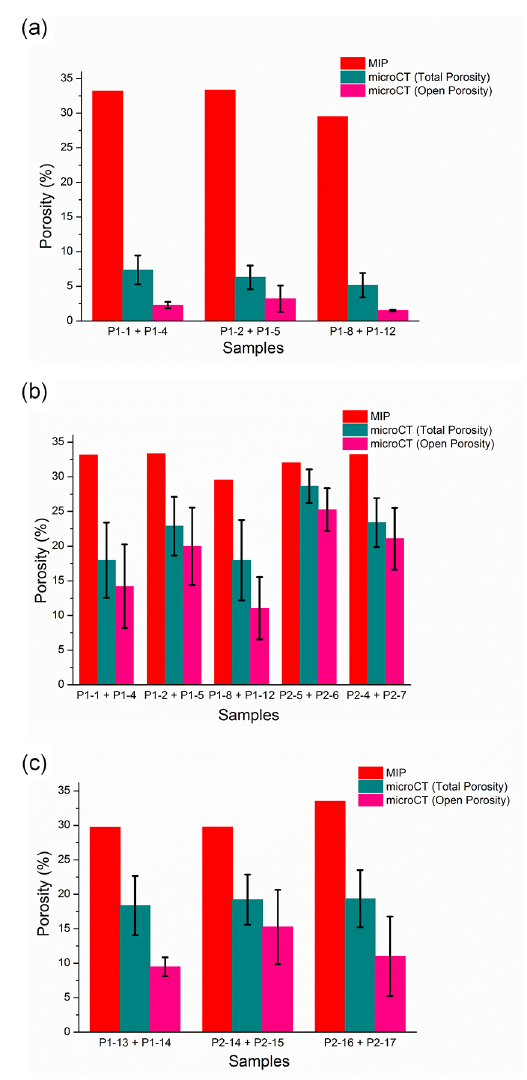
Figure 15. Comparison of porosities: microCT x MIP: (a) 0.4X-8µm; (b) 4X-4µm; (c)